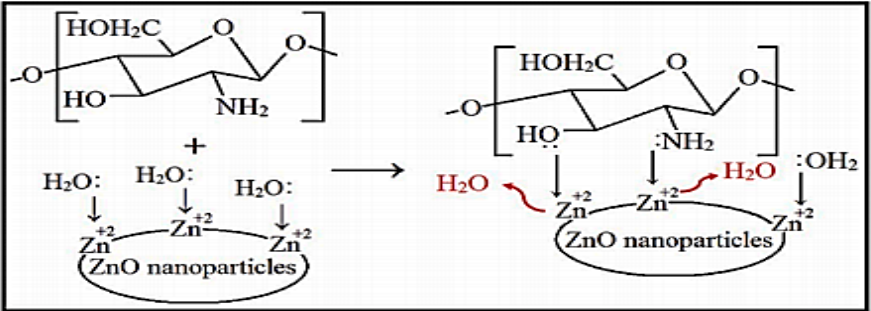
Figure 5. Complexation reaction between chitosan functional groups and Zn +2 ions of ZnO nanoparticles (taken from [46]).